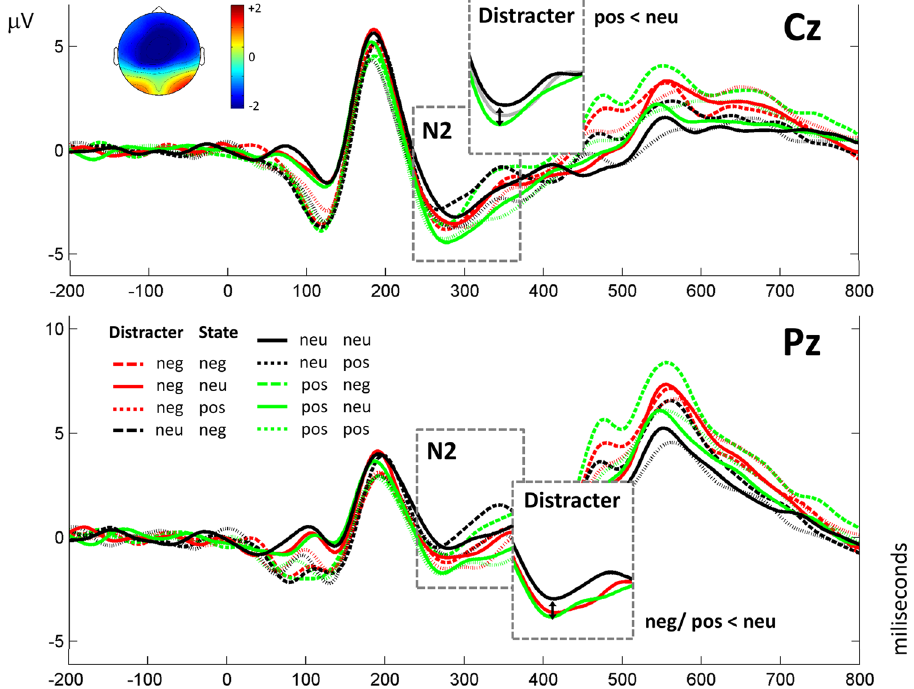
Figure 2. N2 results. Grand averages are presented at Cz and Pz, where results are clearly visible, including all conditions. Significant results at each topography are depicted in